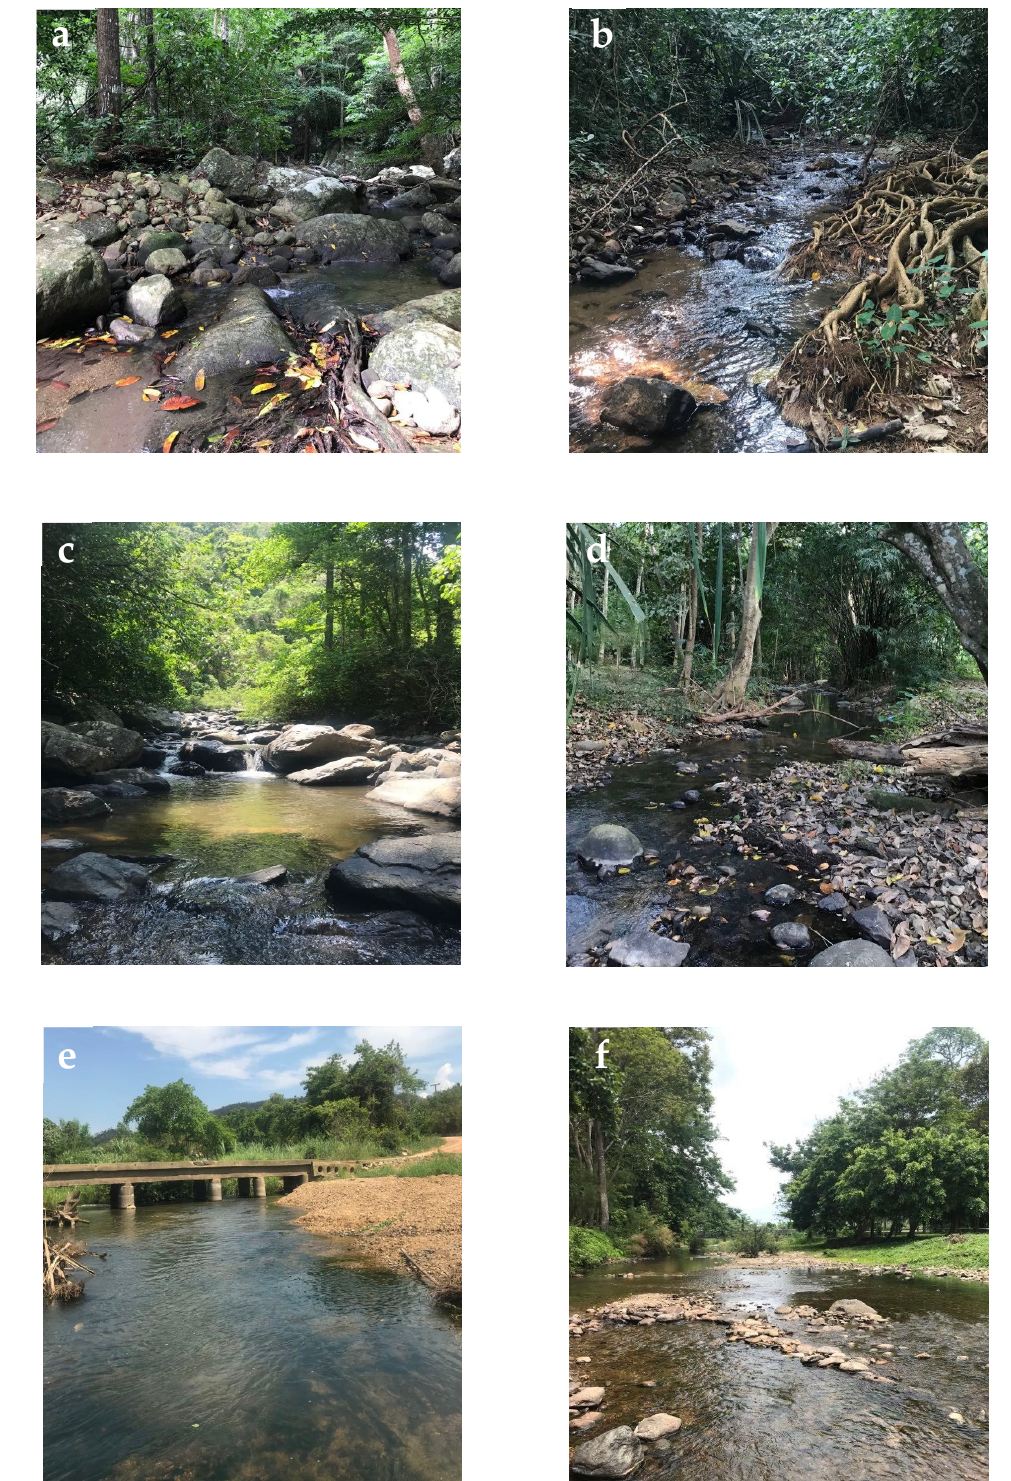
Figure 2. Protected sampling sites located inside the national park: ( a ) Mae Kra Dung La Waterfall (MWF); ( b ) Ban Krang (BK); ( c ) Pa La-U Waterfall (PWF), and unprotected sampling sites located outside the national park: ( d ) Mae Kra Dung La Stream (MS); ( e ) Huai Sat Yai (HSY); ( f ) Huai Palaw (HPL).